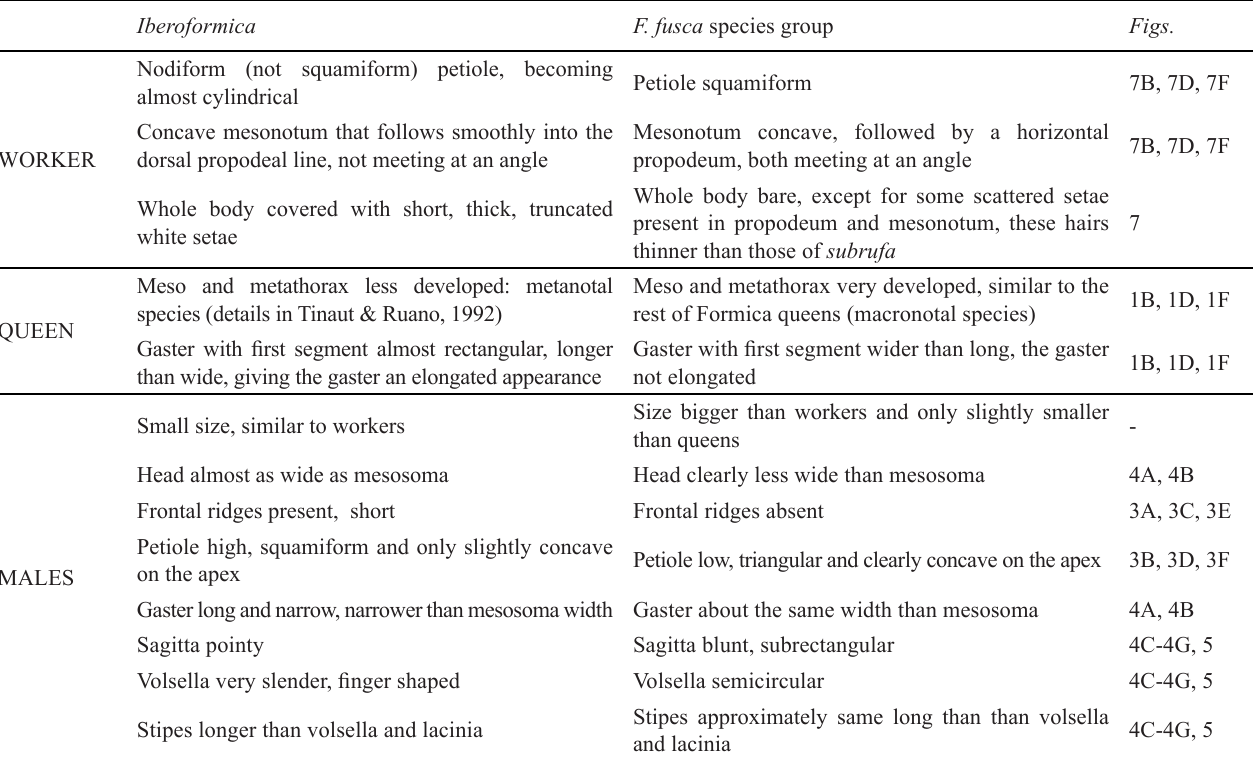
Table 2. Comparison of morphological characters between the genus Iberoformica and subgenus Serviformica .